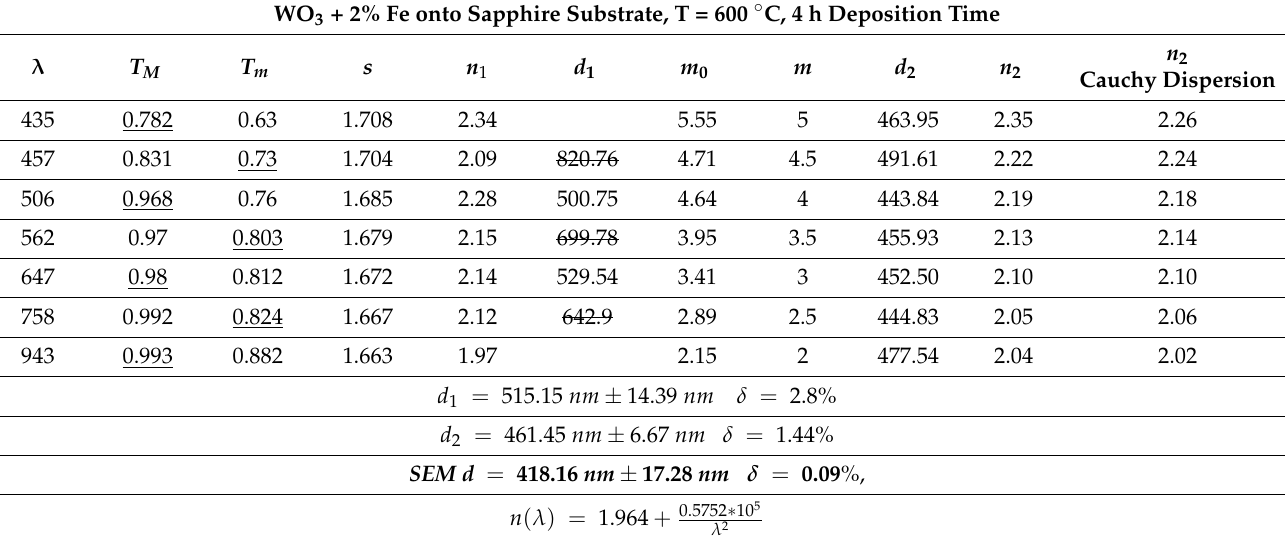
Table 1. The parameters obtained for WO 3 + 2% Fe layer samples grown at T = 600 ◦ C and 4 h deposition time.